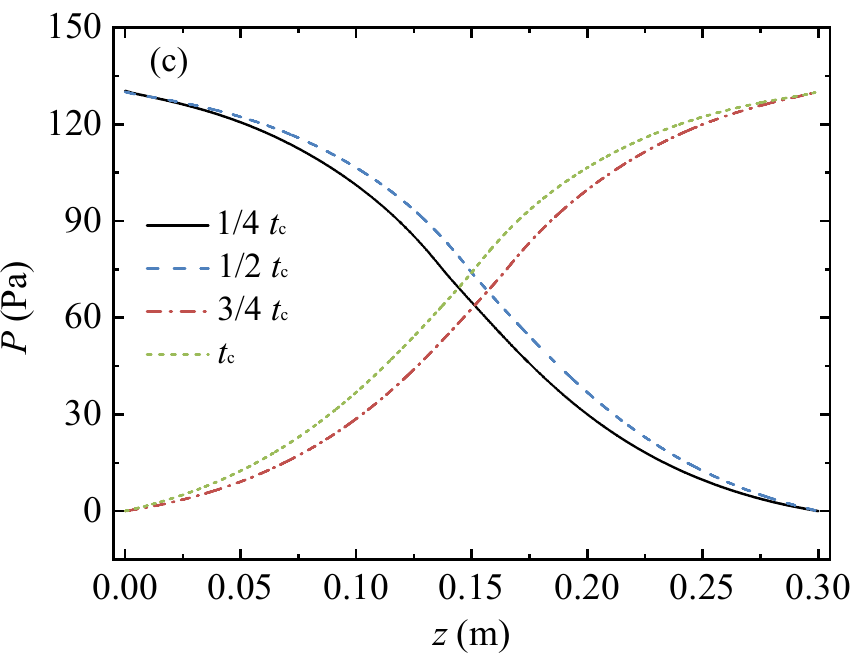
Figure 2. Migration process of the gas temperature, methane volume fraction, and pressure profiles along the arial direction in a full cycle: ( a ) gas temperature profiles, ( b ) profiles of methane volume fraction, and ( c ) pressure profiles.